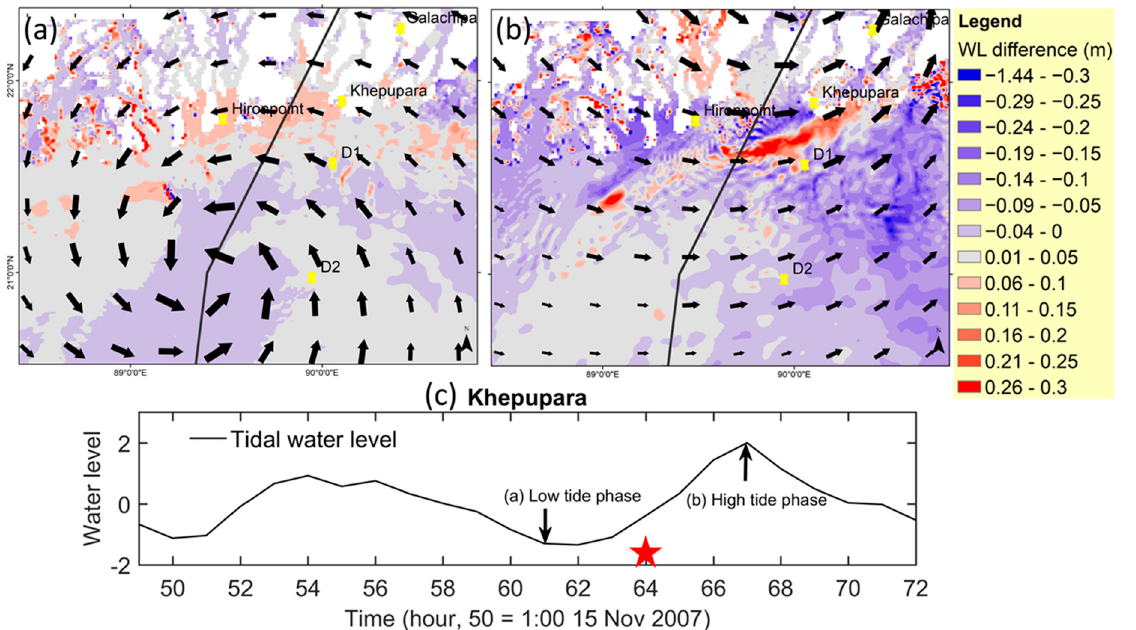
Figure 6. Difference in the water level between the run with waves (Run1 in Table 2) and the run without waves (Run5) at: ( a ) Low tide at 1200 UTC 15 November; ( b ) High tide at 1800 UTC 15 November 2007; and ( c ) Time series of the tidal water level variations (Run2) at Khepupara. The water level difference is calculated as Run1 minus Run5. Positive (negative) water level difference denotes wave setup (setdown). The length of the vector represents wind speed (max = 50 m s − 1 ). The red star in panel ( c ) denotes the landfall time, 1500 UTC 15 November 2007.